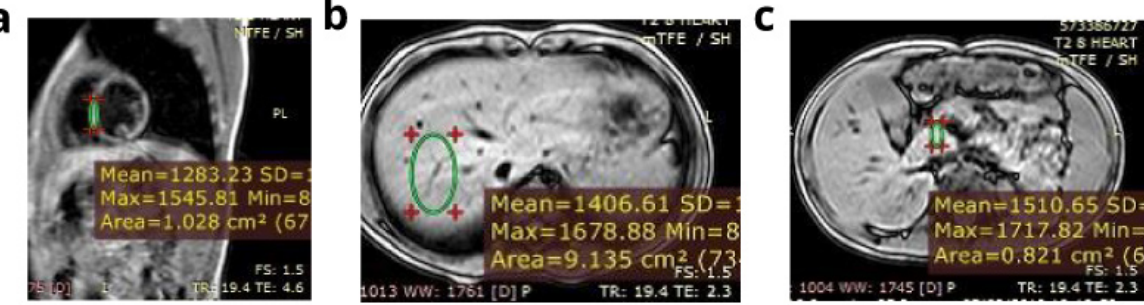
Figure 1. Magnetic resonance imaging of a patient with moderate cardiac iron overload, normal hepatic and pancreatic iron concentration. a ) Calculated myocardial T2* equals 13.3 ms and myocardial iron concentration equals 1.91 mg/g (moderate cardiac iron overload). b ) Calculated hepatic T2* equals 26.5 ms and liver iron concerntration equals 0.60 mg /g (no hepatic iron overload). c ) Calculated pancreatic T2* equals 40 ms (no pancreatic iron overload). Conclusion: The patient has moderate cardiac iron overload, normal hepatic and pancreatic iron